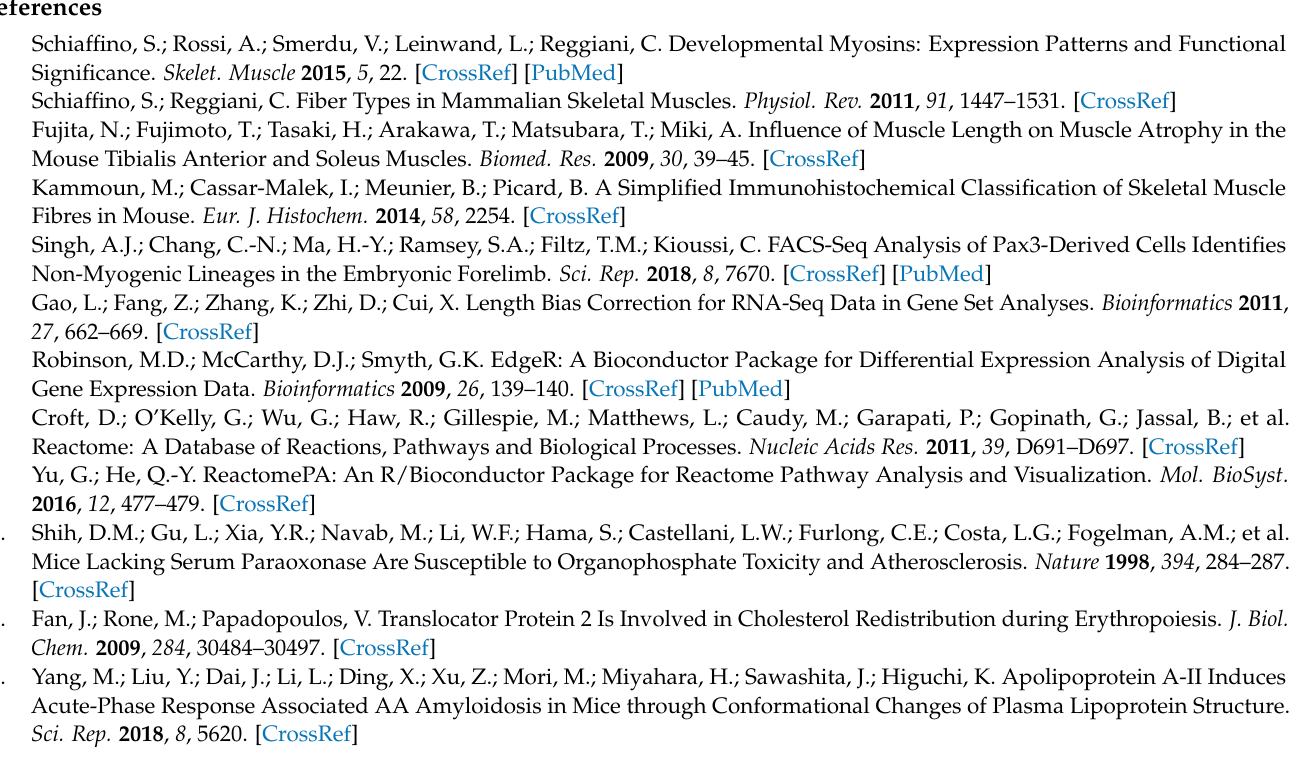
Table S1. Differentially Expressed Genes in So and Ta involved in Ion Transport and Glycosamino- glycan biosynthesis pathways, Table S2. Differentially Expressed Genes in So and Ta organized by Immune Response, Signaling, and Cellular function